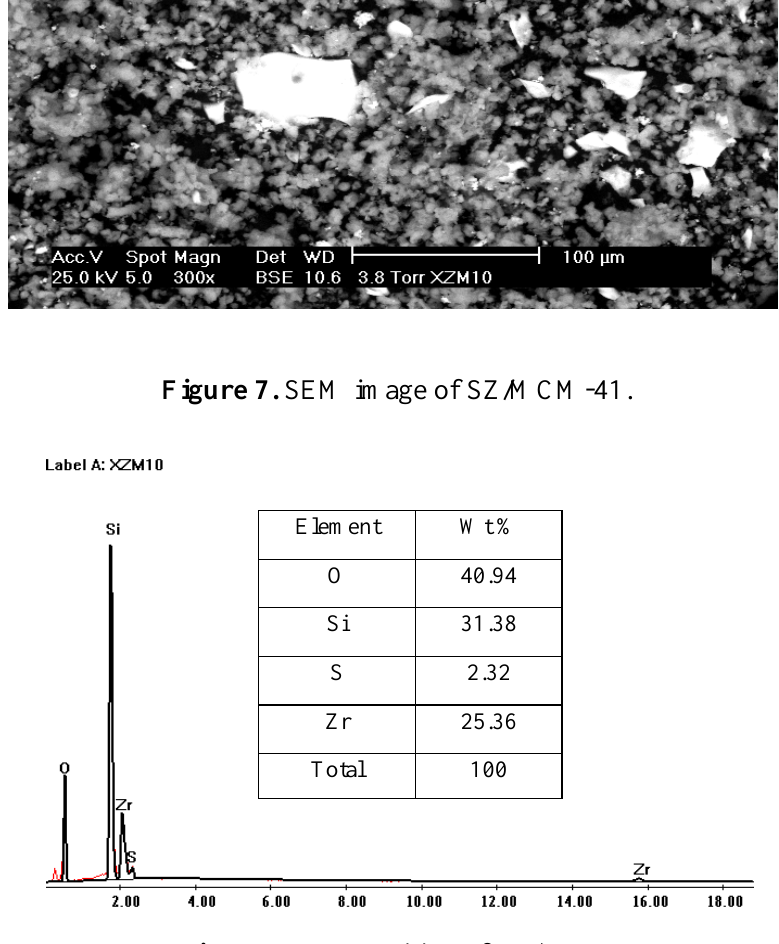
Figure 8. Composition of